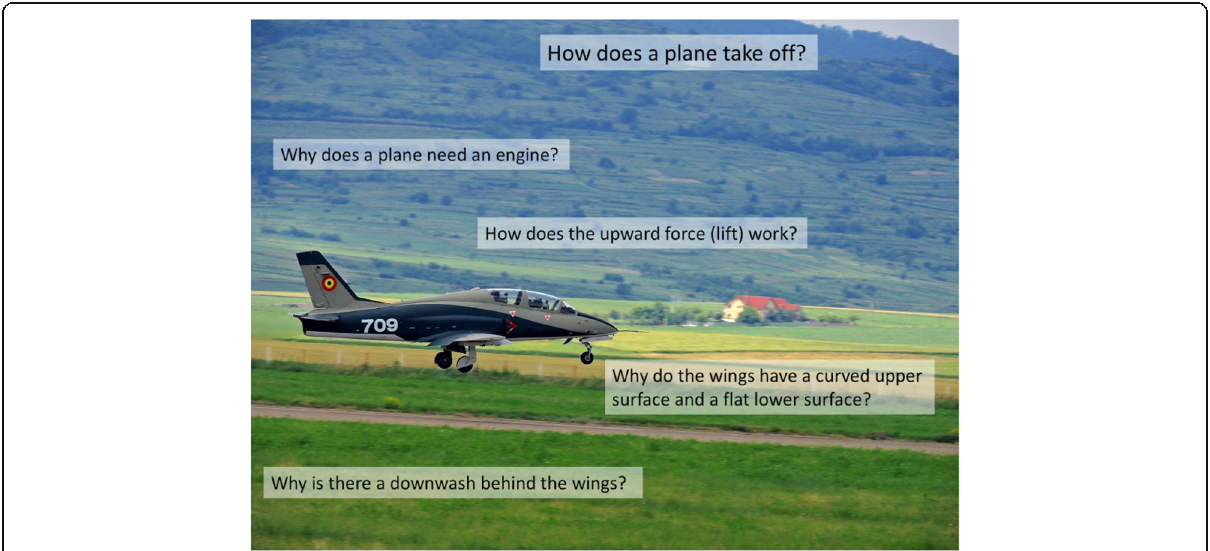
Fig. 4 Illustration of “ how ” and “ why ” questions (i.e., elaborative interrogation questions) students might ask while studying the physics of flight.